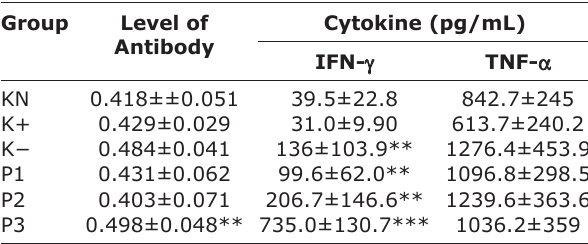
Table-1: Effect of polysaccharide from Caribena versicolor on the level of antibody, IFN- γ , and TNF- α . Group